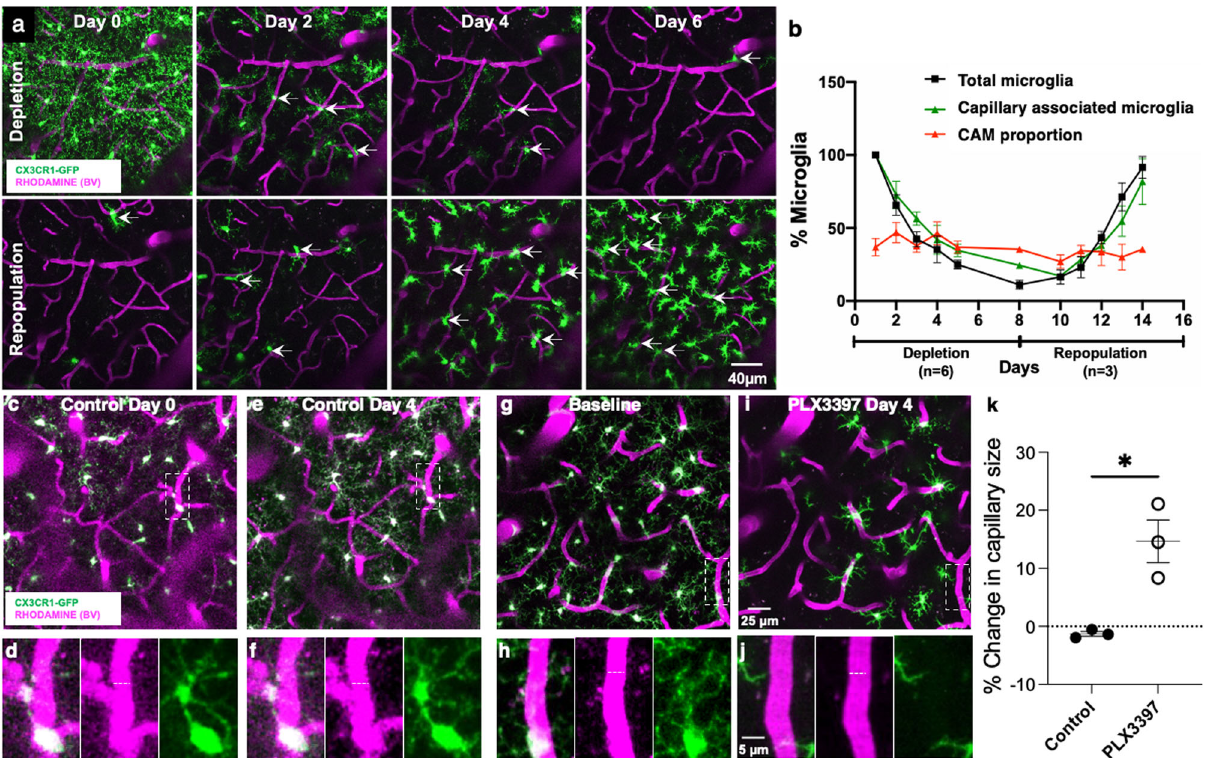
Fig. 6 Microglia regulate capillary diameter. a Representative 20- µ m-thick in vivo two-photon projection image from a CX3CR1 GFP/ + adult brain during longitudinal imaging with PLX3397 treatment (top) and withdrawal (bottom) showing microglial (green) depletion and repopulation with the preservation of the vasculature (magenta). b Quanti fi cation through the time of the depletion and repopulation scheme for all microglia and capillary-associated microglia as well as the proportion of CAMs relative to remaining microglia. n = 4 mice. c – f Representative two-photon projection image from